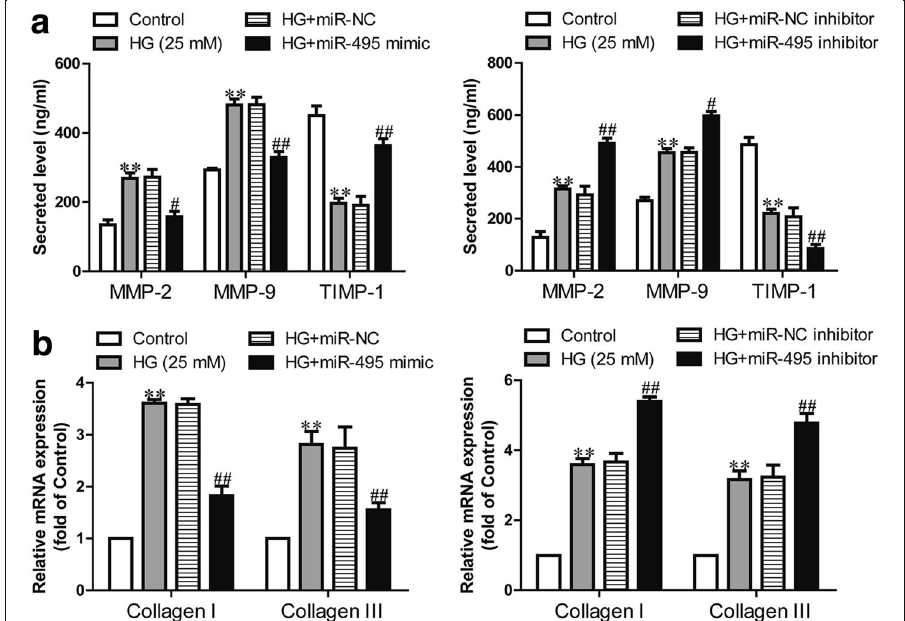
Fig. 4 Effects of miR-495 on high glucose-induced imbalance of MMP-TIMP and collagen synthesis in human CFs. CFs were transfected with miR-495 inhibitor or mimic for 48 h, and then treated with 5.5 or 25 mM glucose for 24 h. HG + miR-NC indicates CFs transfected with the miR-495 inhibitor before treatment with high glucose; HG + miR-495 mimic indicates CFs transfected with the miR-495 mimic before treatment with high glucose. a The secreted MMP-2, MMP-9 and TIMP-1 proteins in the supernatants of CFs were detected using ELISA assays. b The mRNA expressions of collagen I and III were determined via quantitative RT-PCR. The data shown are means ± SEM ( n = 6). ** p < 0.01, vs. control; # p < 0.05, ## p < 0.01 vs. vehicle + high glucose. The vehicle is transfection reagent